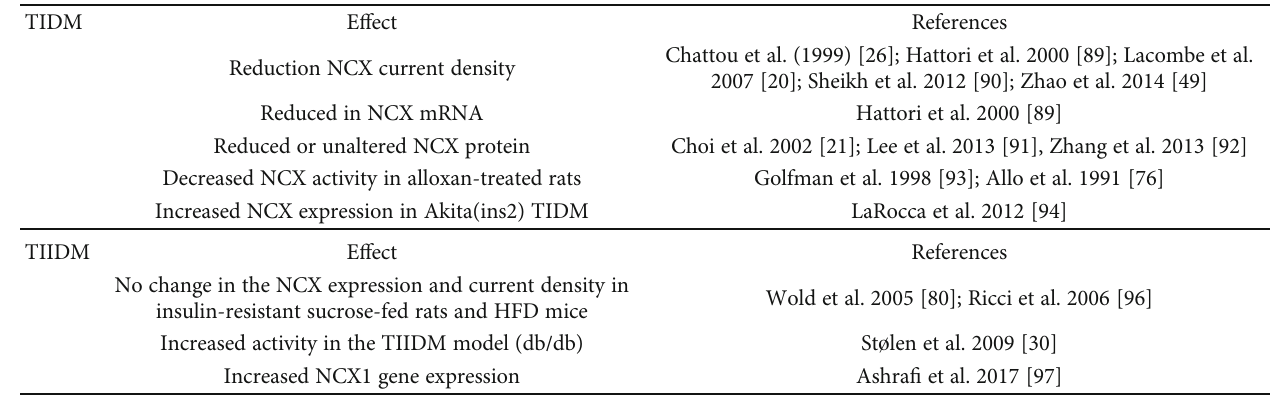
Table 4: E ff ect of DM on sodium-calcium